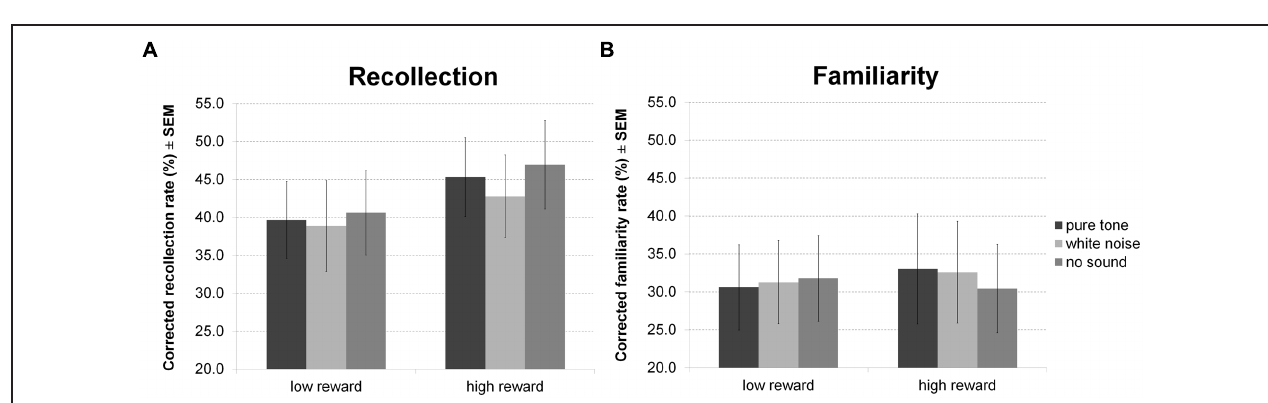
FIGURE 7 | Reward based long-term memory task: encoding. The figure depicts mean accuracy (A) and mean RT (B) together with the standard error of the mean (SEM) during encoding by sound condition and reward in Experiment 4.